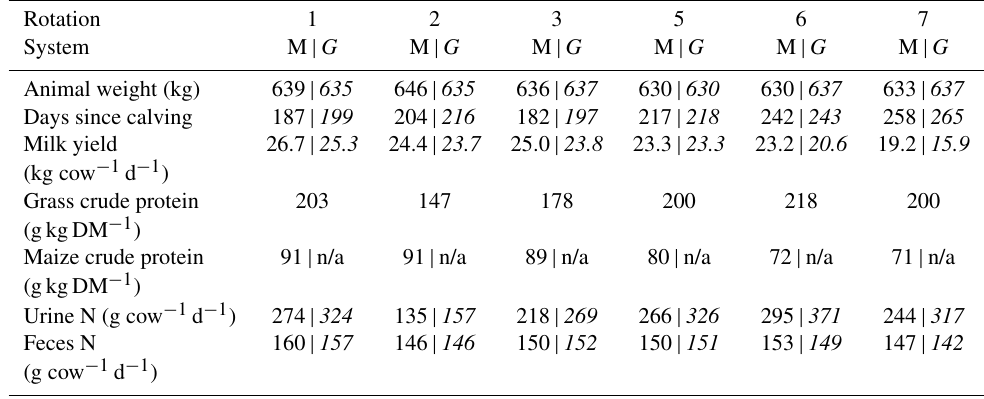
Table 2. Measured driving parameters and resulting urine N and feces N of the animal N budget model averaged for the individual rotations and for each herd (system M | G ). If only one number is given it corresponds to both herds simultaneously. Rotation 4 is not shown due to missing miniDOAS